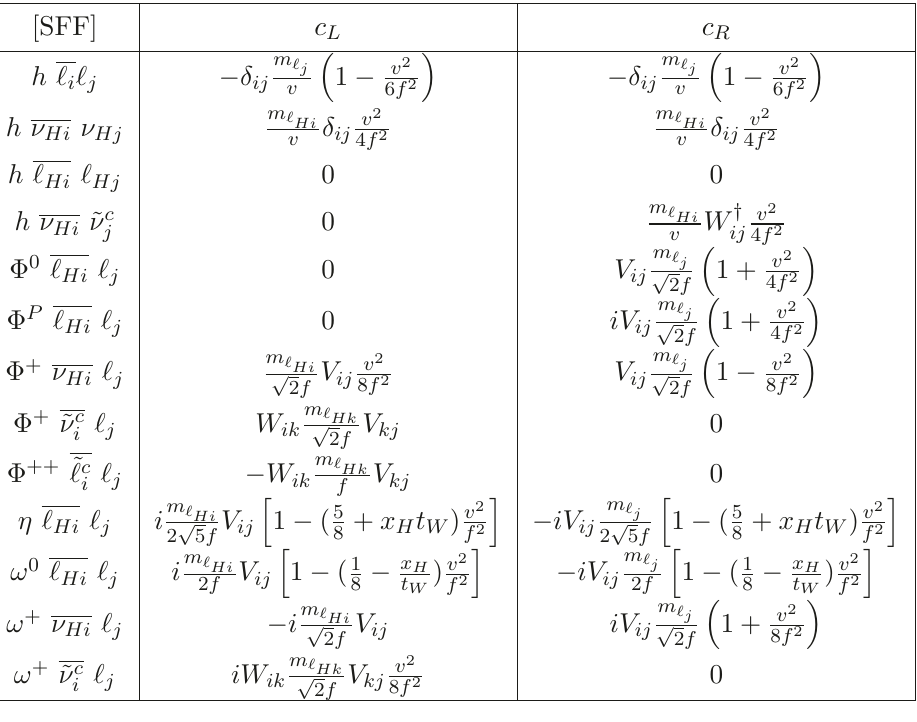
2 ). We use t W = tan θ W = s W ( v f 2 O ℓℓ ′ , but it does in Z, γ →